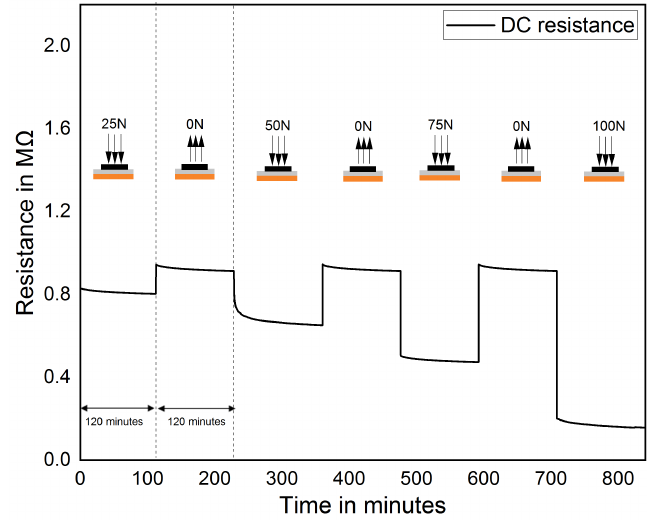
Figure 8. Drift test for MWCNT/PDMS pressure sensor at different pressure applied on it.